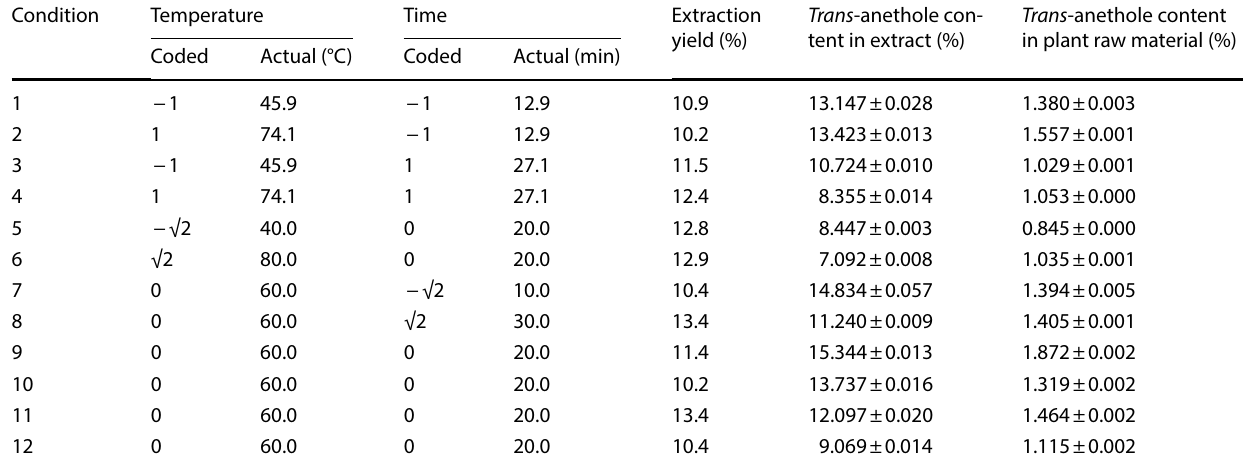
Table 1 Circumscribed central composite experimental design and results of responses, i.e., extraction yield, trans -anethole content in the extract, and trans -anethole content in the plant raw material